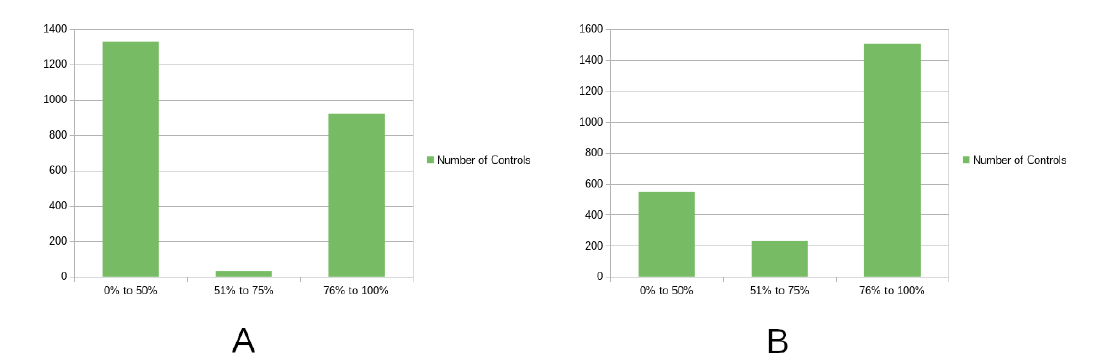
Figure 5. Type 2— Number of Controls by Acceptance Percentage Intervals on the first auditing ( A ); and on second auditing ( B